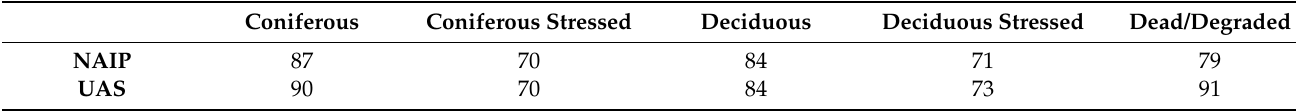
Table 1. Reference data sample sizes for each forest health class for both the NAIP and UAS imagery digital classifications. Coniferous Coniferous Stressed Deciduous Deciduous